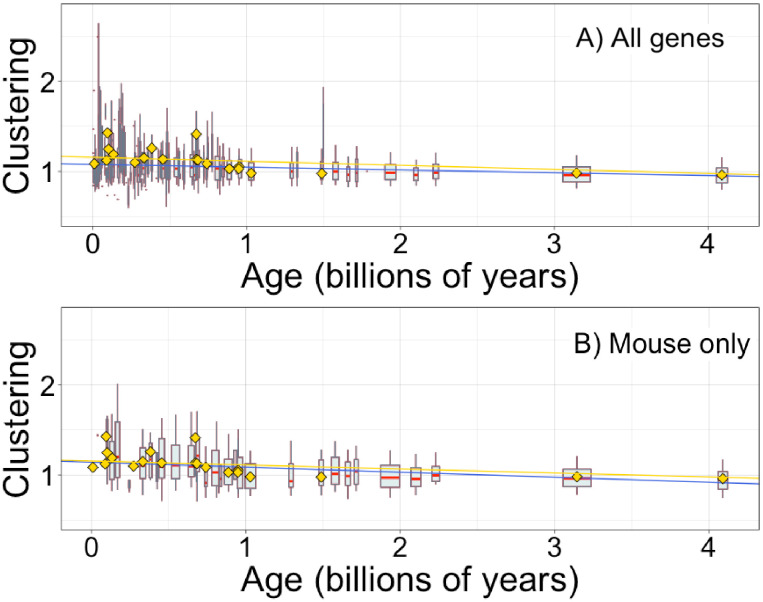
Hydrophobic clustering of complete genes depends on age, as previously reported by Foy et al., 2019.Clustering has an expected value of 1 for randomly distributed amino acids. Each data point consists of the average across all instances of homologous pfams, across all species in which it occurs. Phylostratigraphy assigns these to age classes, dated using timetree. Each age class is represented by a weighted box plot, where the width of the plot indicates the number of pfams in that age class. The median is shown in red, with the boxes representing upper and lower quartiles (the 75th and 25th percentile), and the whiskers indicating 9 and 91 quantiles. For age classes with only a single pfam, values are presented as small red dots. For clarity of presentation our plots do not show outliers, although we note that these are included in our linear regression models. The relationship is a little weaker for all genes (A; blue linear regression slope = −0.031, R2 = 0.033, p = 5 × 10−132) than it is for genes found in mouse (B; blue linear regression slope = −0.056, R2 = 0.060, p = 4 × 10−56). In both plots, yellow points show the average clustering scores taken from Foy et al., 2019 mouse gene analysis, with corresponding yellow linear regression, slope = −0.045, R2 = 0.067, p = 8 × 10−221. Our improved gene age assignments thus increased the strength of the relationship for mouse genes, where the relationship is stronger than for genes across all taxa.